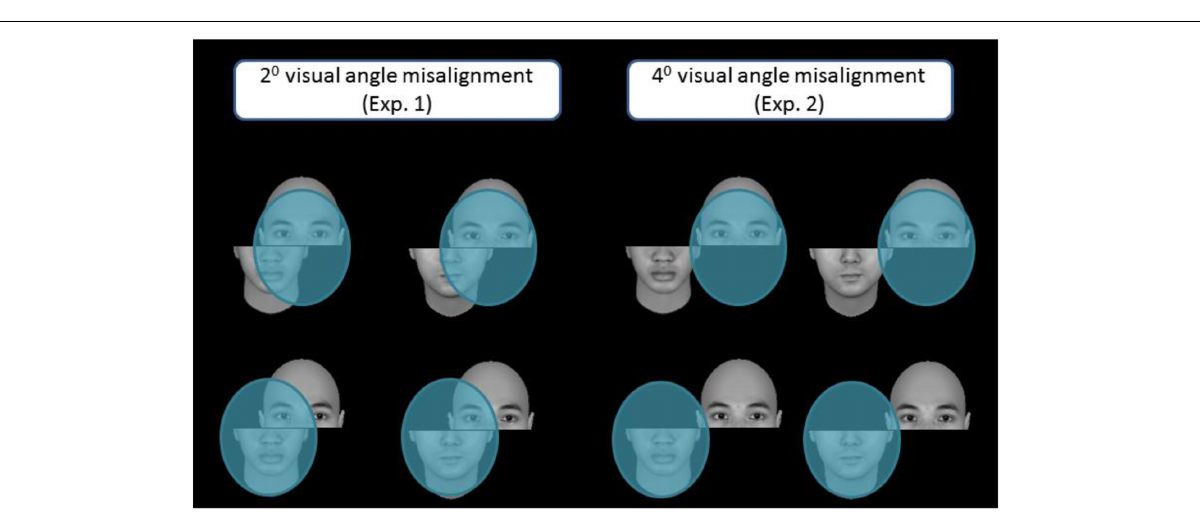
FIGURE 6 | An illustration of the perceptual field (blue ovals) and its distribution in the misaligned condition when either the top part (top row) or bottom part (bottom row) was the target. Note the blue ovals presumably depict the extent of the perceptual field for upright faces. When participants focus on the top part, the perceptual field contains more facial features than when they focus on the bottom part. Note also the difference in the content of the perceptual field when the top and bottom parts were moderately separated, as in Experiment 1 (left half of the figure), as opposed to when they were completely separated, as in Experiment 2 (right half of the